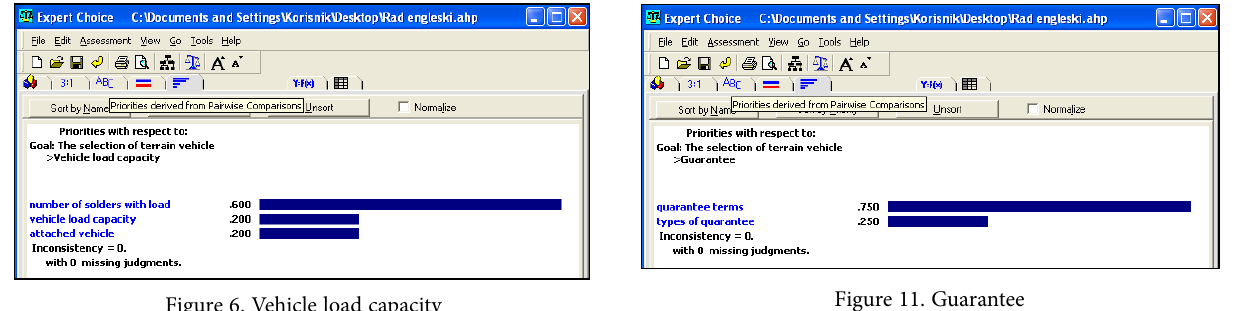
Figure 6. Vehicle load capacity